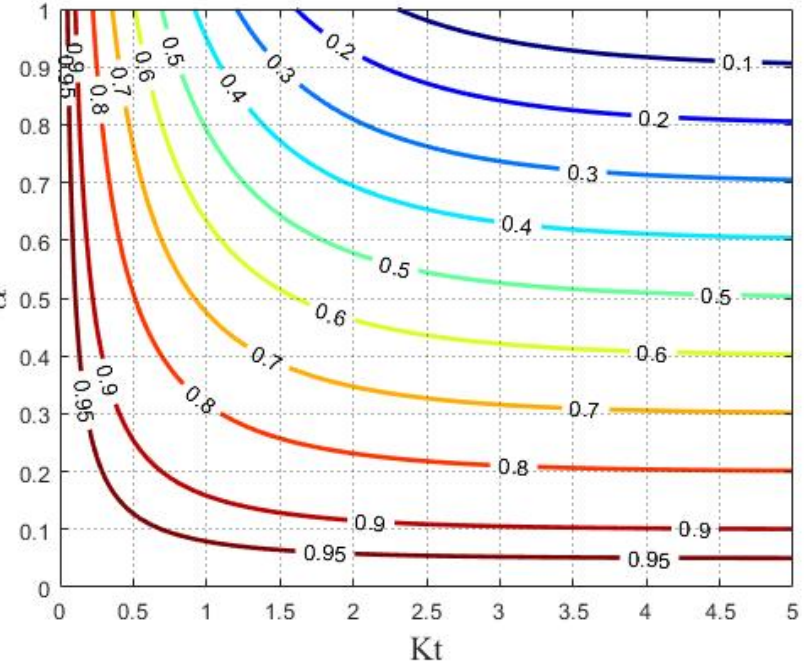
Figure 8. Diagram of predicted change in background erosion shoreline (dimensionless unit).